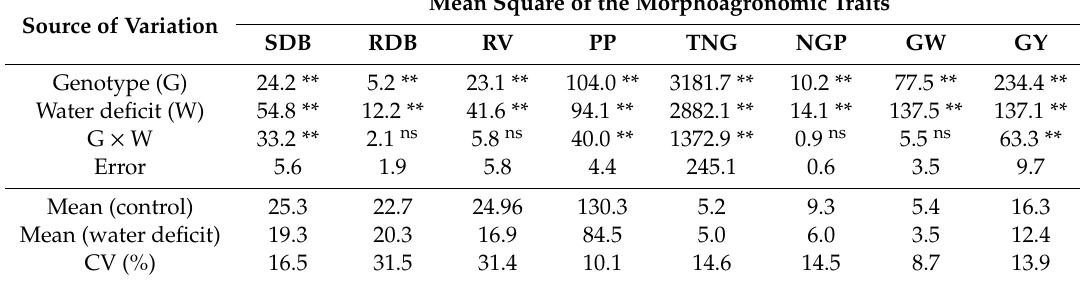
Table 2. Analysis of variance, means, and coe ffi cient of experimental variation (CV) of four common bean cultivars evaluated under water-stressed and unstressed conditions. Mean Square of the Morphoagronomic Traits Source of Variation SDB RDB RV PP TNG NGP GW GY Genotype